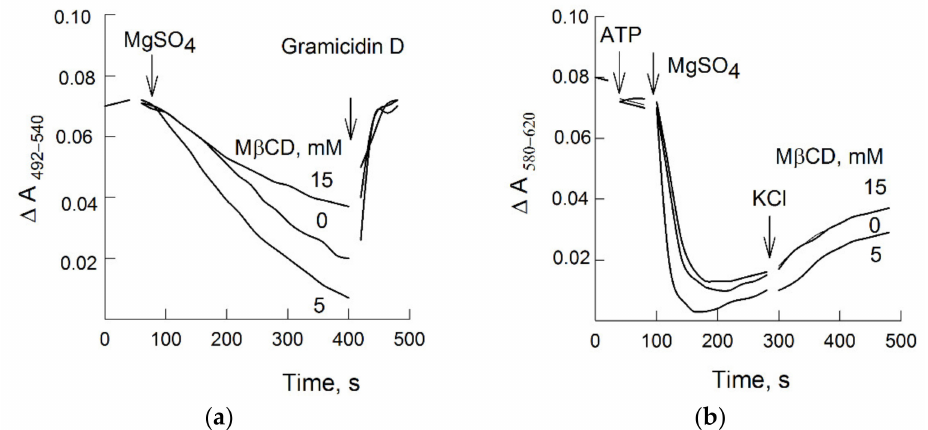
Figure 4. Generation of ∆ pH ( a ) and ∆Ψ ( b ) by plasma membrane vesicles with different sterol contents. Sterols were extracted by treatment of plasma membranes in the presence of different M β CD concentrations, and then, vesicles were washed from sterols/M β CD complexes by centrifugation. Sterol content was as shown in Table 2. ATP-dependent ∆ pH and ∆Ψ were dissipated by 2 µ M Gramicidin D and 50 mM KCl, respectively. Representative kinetics curves are presented. Table 2. Kinetic parameters of ATP hydrolysis by plasma membrane vesicles with different sterol contents in the absence or presence of dodecyl maltoside (DDM). Sterols were extracted by treatment of plasma membranes in the presence of different M β CD concentrations, and then, vesicles were washed from sterols/M β CD complexes by centrifugation. Before ATP, 10% DDM was added into a measuring cell at a detergent/protein ratio of 7:1 ( w/w ). Data from two independent sterol extractions are presented. * indicates significant ( p < 0.05) differences compared with the initial plasma membranes. M β